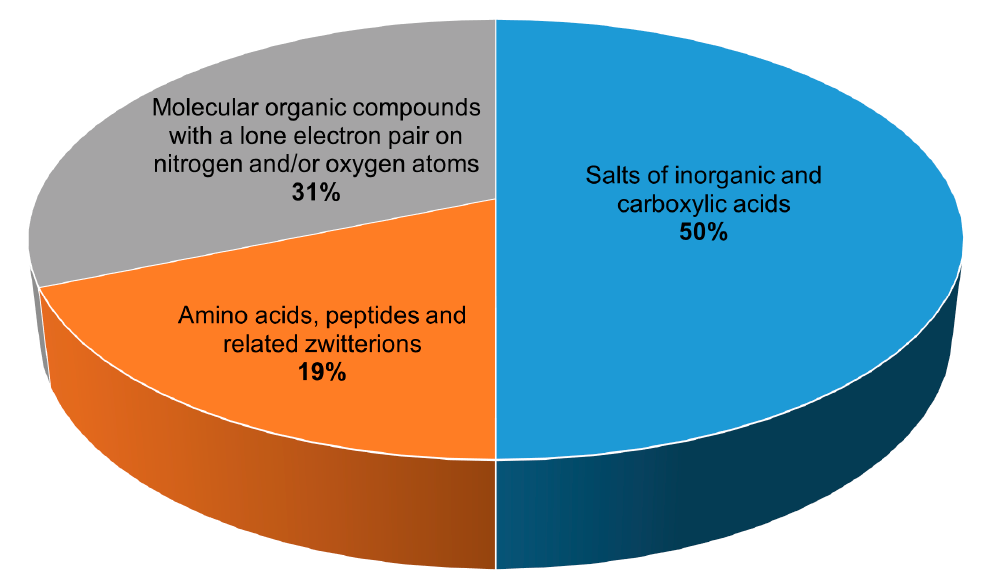
Figure 2. Distribution of peroxosolvates by the chemical nature of the coformer.